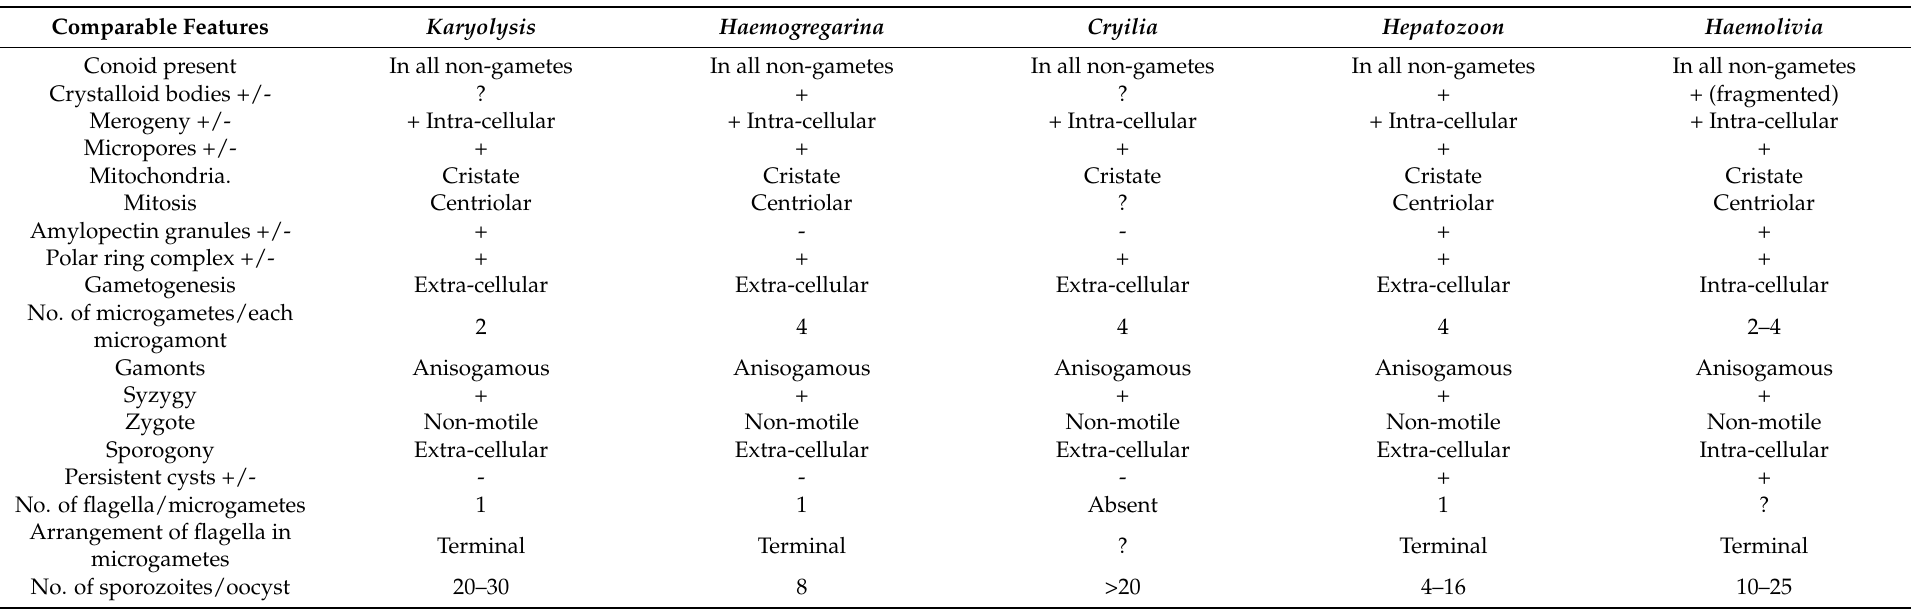
Table 1. Characters of different groups of haemogregarines used in the parsimony analysis carried out by Barta [19] and Siddall and Desser